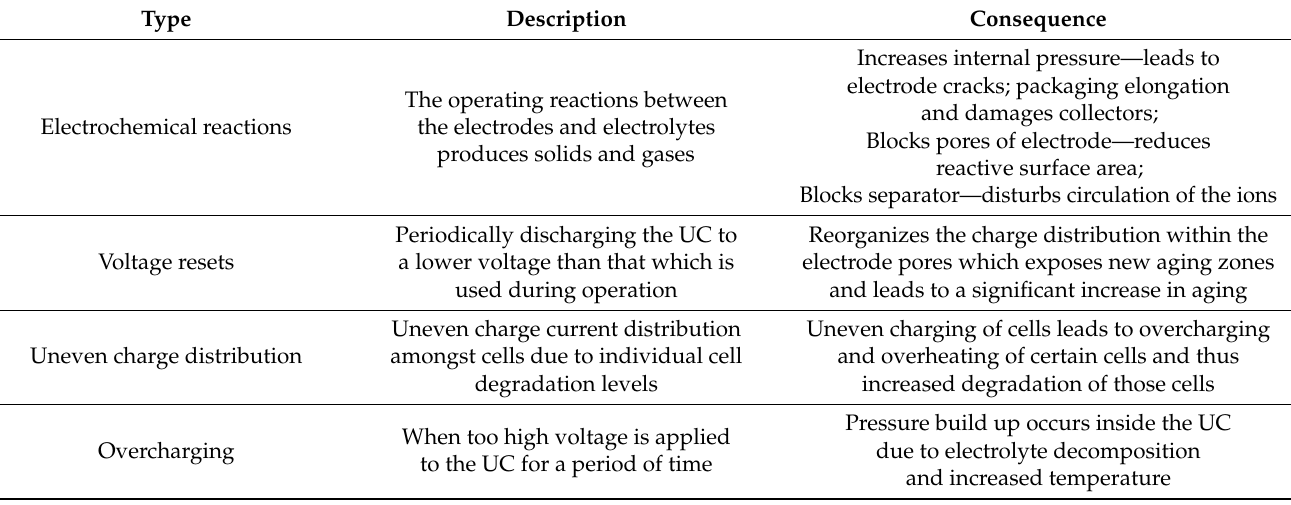
Table 8. Causes of degradation in ultra-capacitors, adapted from